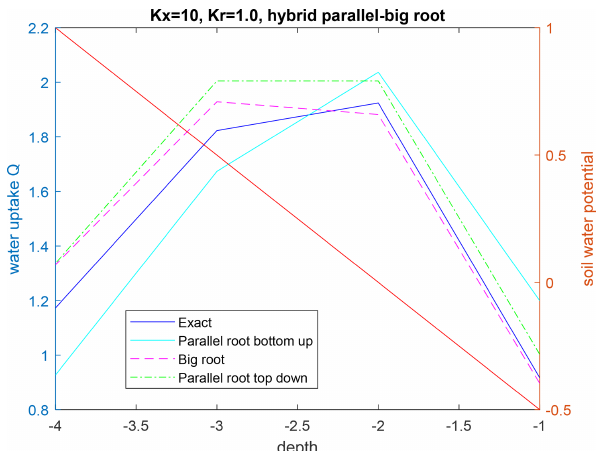
Figure 4. Upscaled water uptake profile (left axis) and soil water potential distribution (right axis; red line) for the hybrid parallel– big root system with constant radial conductances along the primary root branches, with the parallel root model with bottom-up parame- terization ( SUF and K rs derived from the exact model), the big root model, and the parallel root model with top-down parameterization.